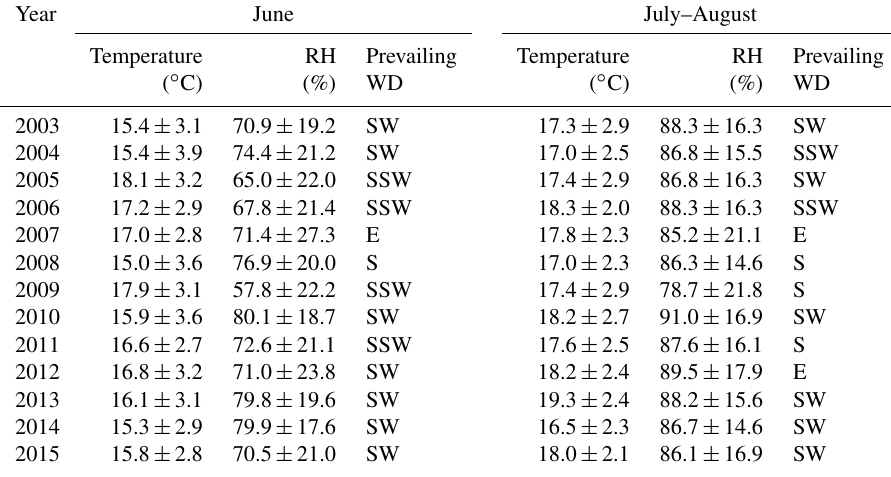
Table 2. Summary of meteorological conditions recorded at Mt. Tai in June and July–August over 2003–2015 ∗ .